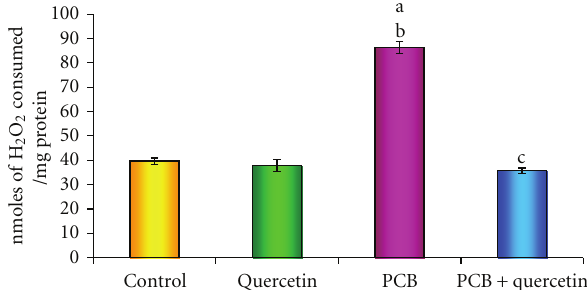
Figure 3: E ff ect of quercetin on lipid peroxidation in hippocampus of PCBs-exposed adult rats. Each bar represents mean ± SEM of 6 animals. Statistical significance is at P < 0 . 05 (a: Control versus others; b: Quercetin versus PCB, PCB + Quer; c: PCB versus PCB +